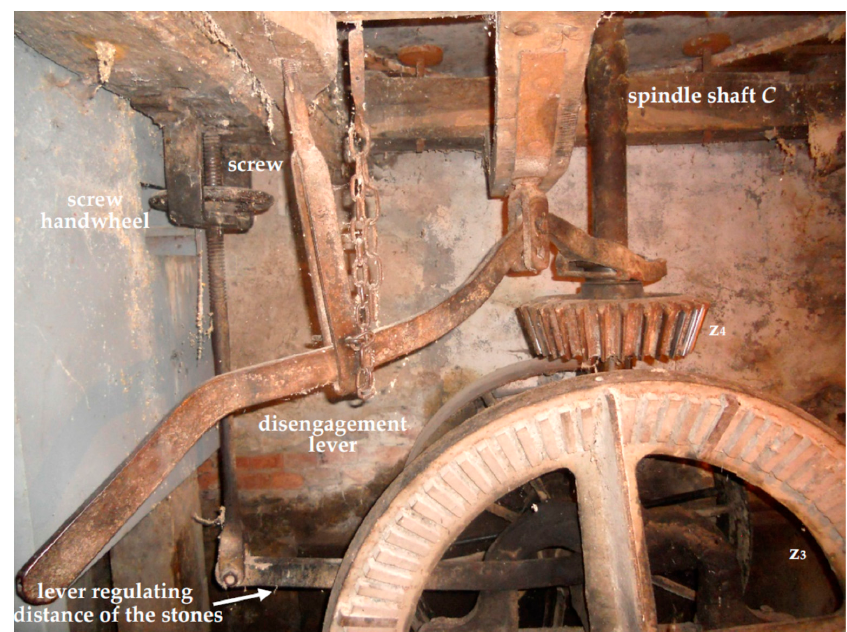
Figure 12. Disengagement of the runner stone and lever for regulation of the distance of the stones in the Forno mill.